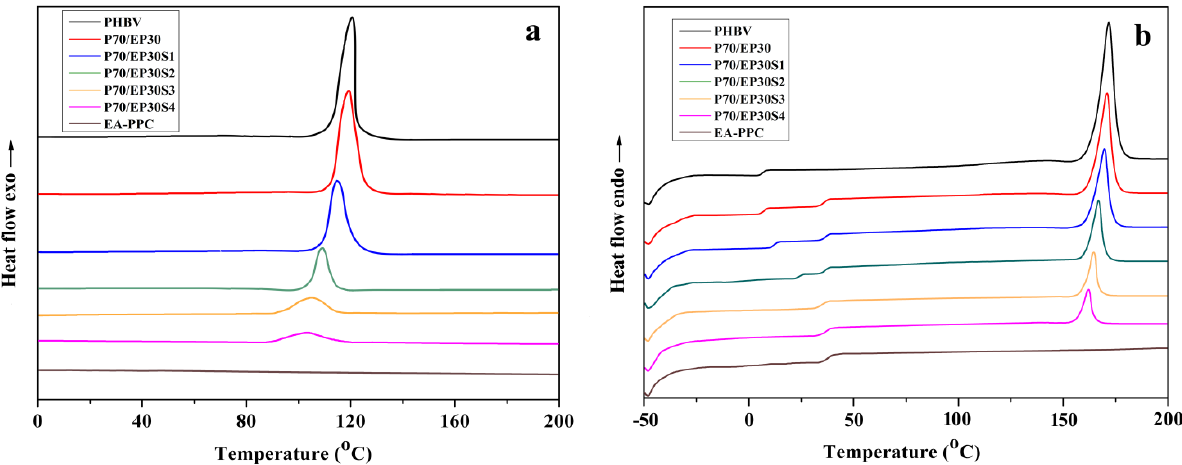
Figure 3. DSC curves of neat PHBV, EA–PPC, and PHBV/EA–PPC blends with various amounts of Sn(Oct) 2 : ( a ) cooling, ( b ) the second heating.